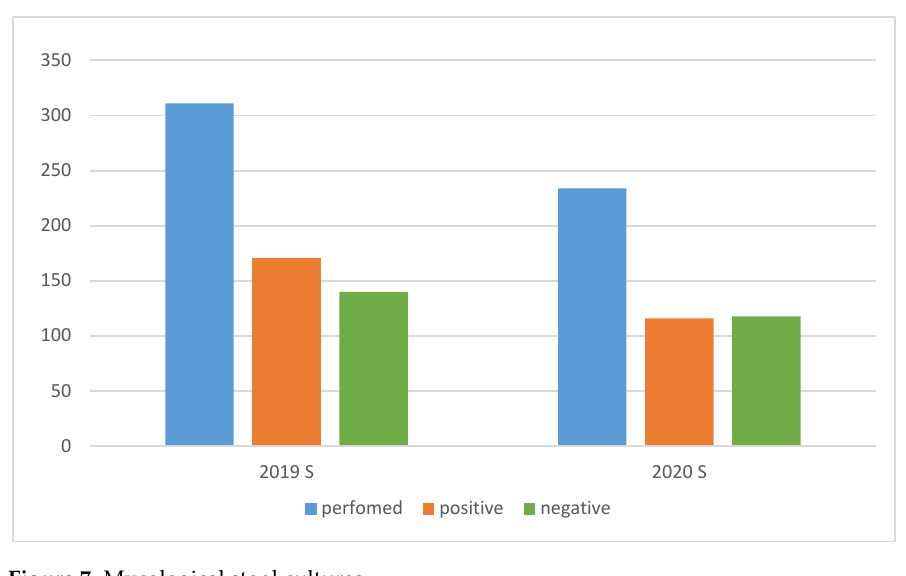
Figure 7. Mycological stool cultures.